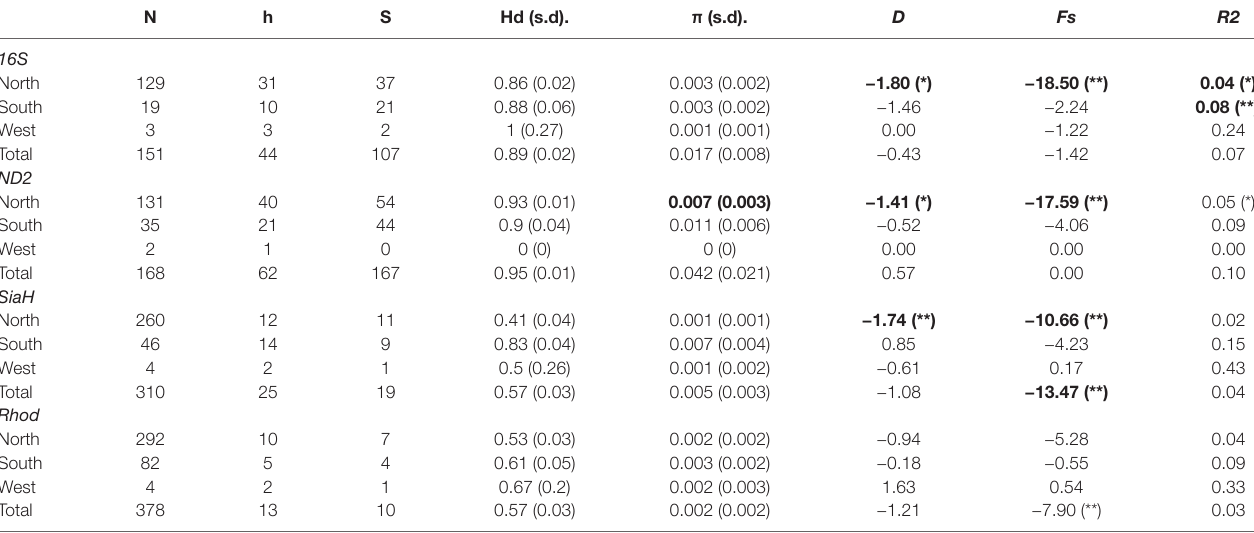
TABLE 4 | Diversity indices and neutrality tests’ result for each BAPS group and for the total datasets of P. nordestinus . N h S Hd (s.d). π